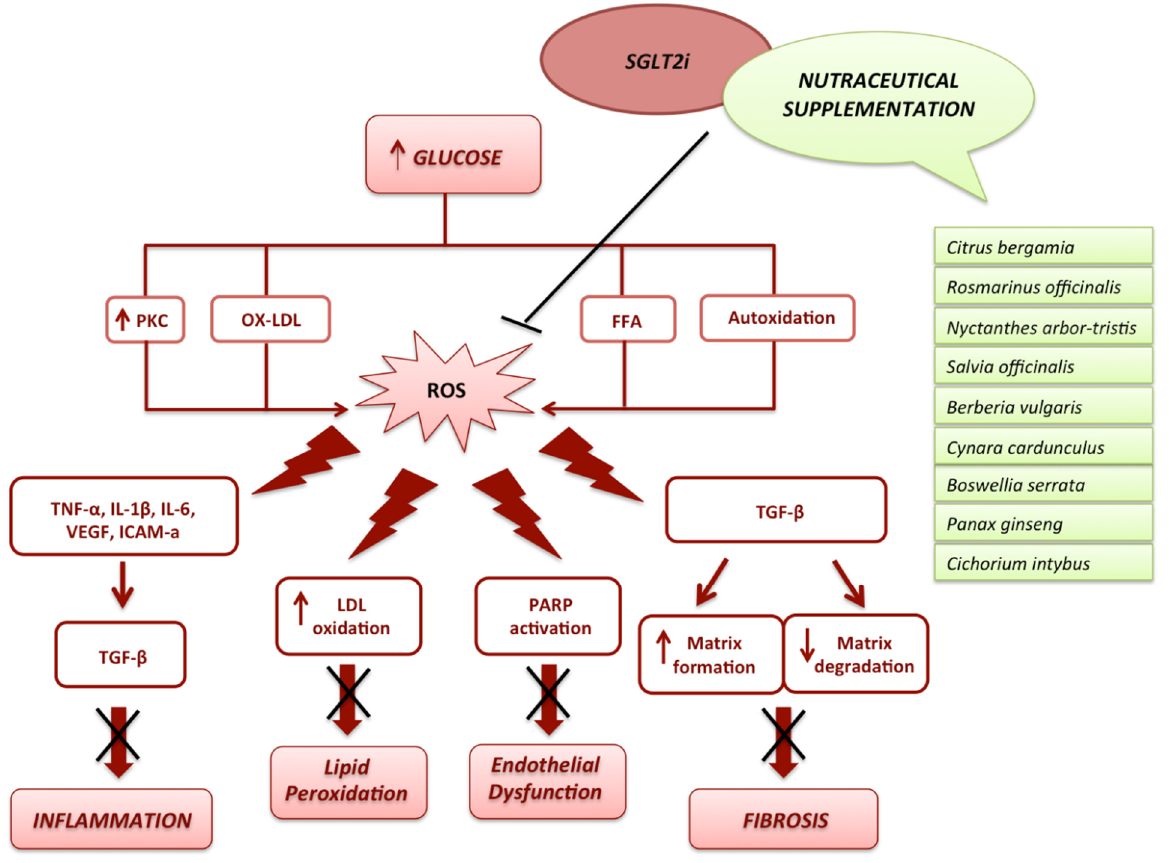
Figure 3. Common cardioprotective effects of the plant extract supplementation and SGLT2 inhibitors. The SGLT2i and several phytocomplexes show a similar action to counteract the ROS production caused by hyperglycemia. In particular, they play a key role in the inhibition of the inflammasome, leading to a reduction in inflammation and fibrosis. The downregulation of LDL oxidation and PARP activation lead to the reduction in lipid peroxidation and endothelial dysfunction.